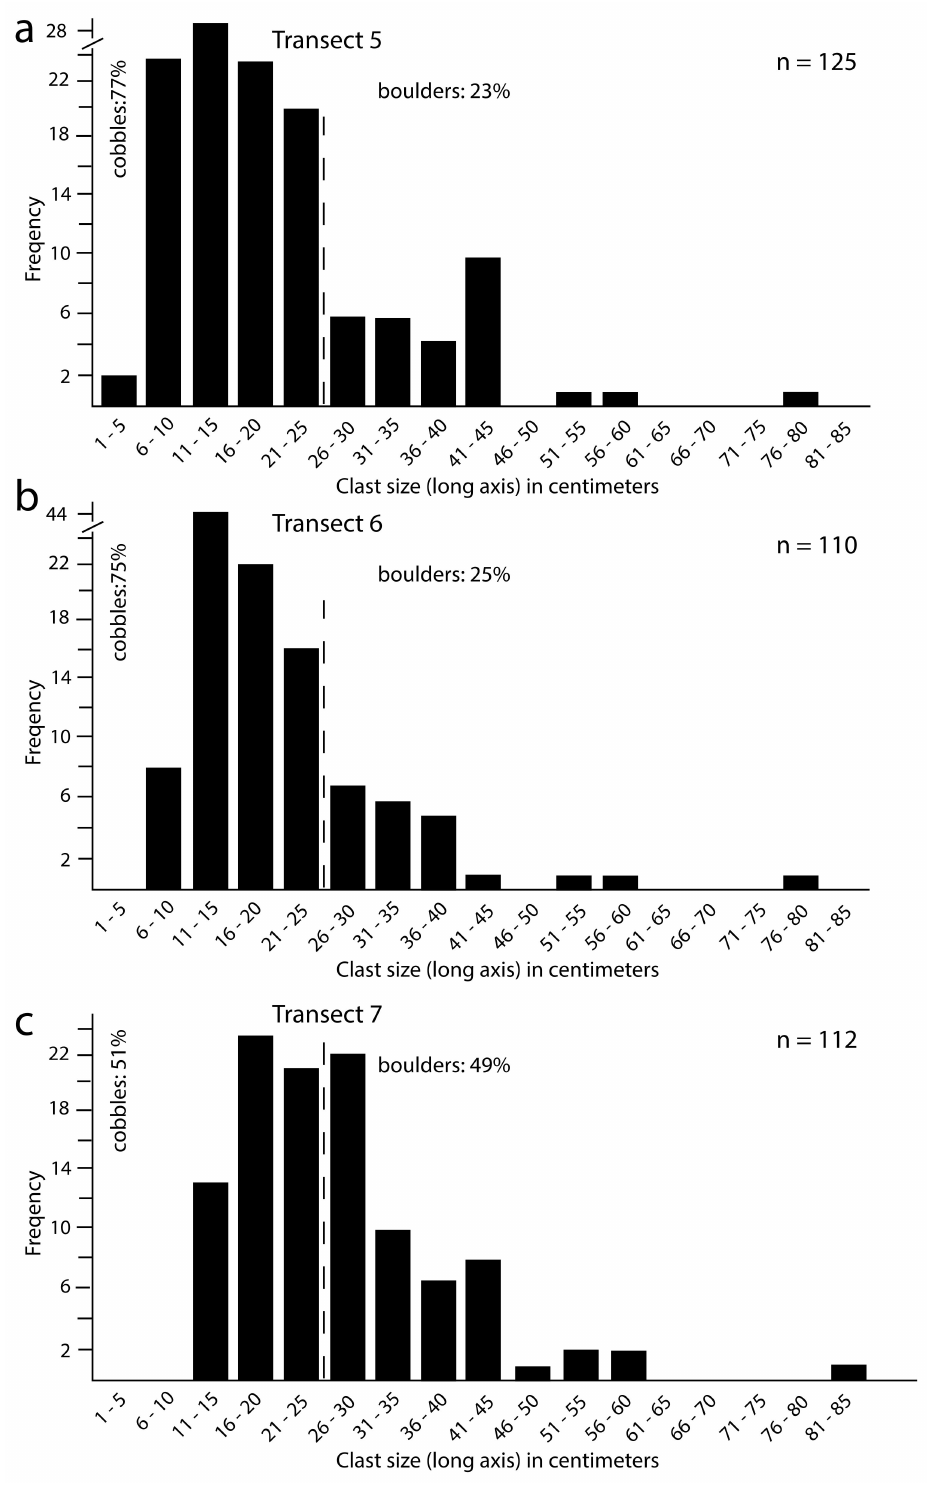
Figure 8. Set of bar graphs used to appraise variations in maximum boulder length from the three transects with similar orientations most distal from the source of coastal erosion; ( a ) Bar graphs from transect 5; ( b ) Bar graphs from transect 6; ( c ) Bar graphs from transect